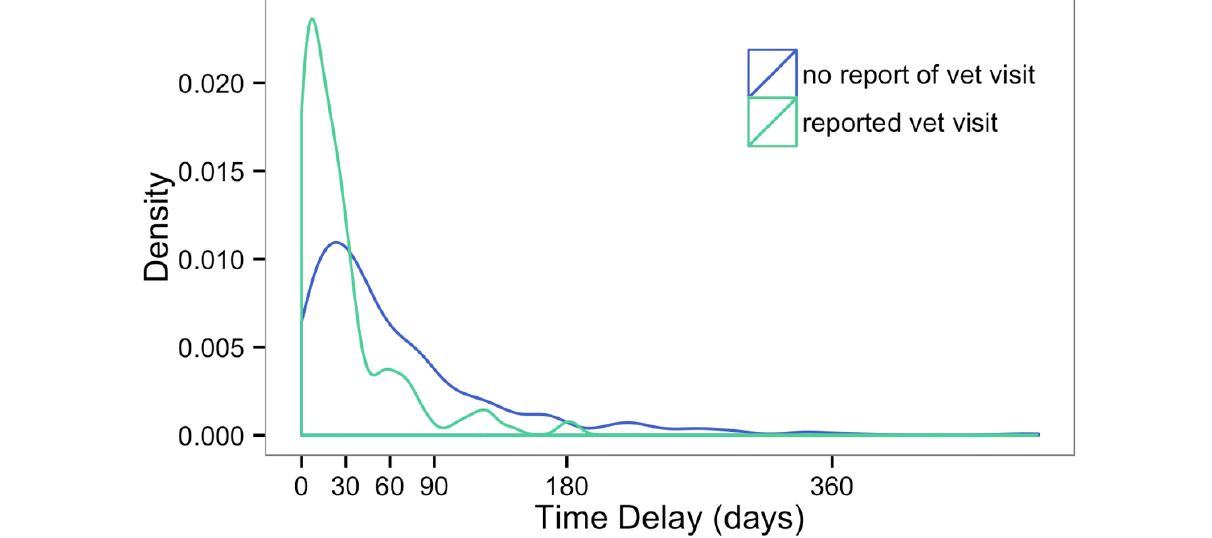
Figure 4. Illness recall decay plot (493 veterinary visits, 101 dogs). Those not reported to Dogslife were illnesses found in the veterinary record but omitted from the Dogslife questionnaire answers